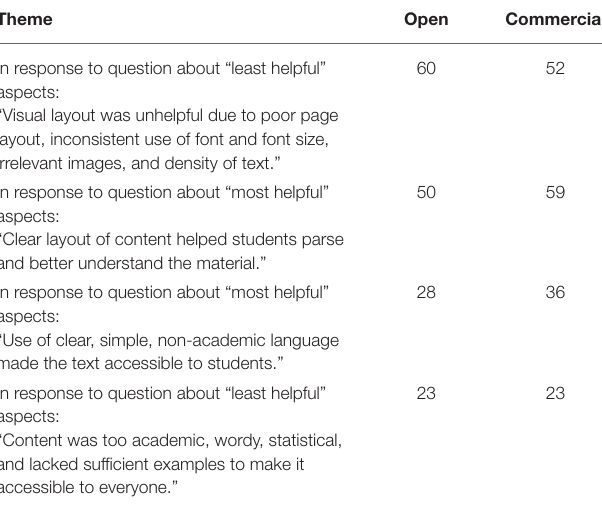
TABLE 3 | Number of references to each theme in open-ended responses by textbook